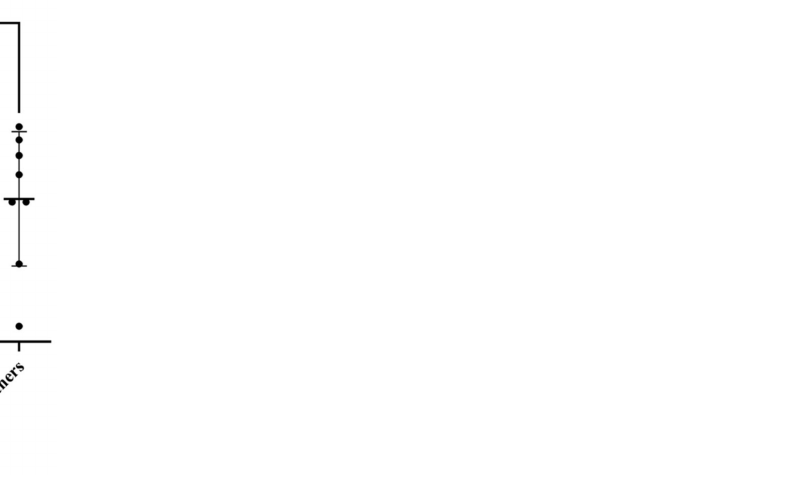
Figure 3. Percentage of H3K27me3 positive cells according to PBRM1 -mutated status in the 12 PDX chordoma models. A significantly higher expression of H3K27me3 in the PBRM1 -mutated compared to non- PBRM1 -mutated PDX models was noted. * achieve statistical significance compared to control ( p < 0.05) by Mann–Whitney